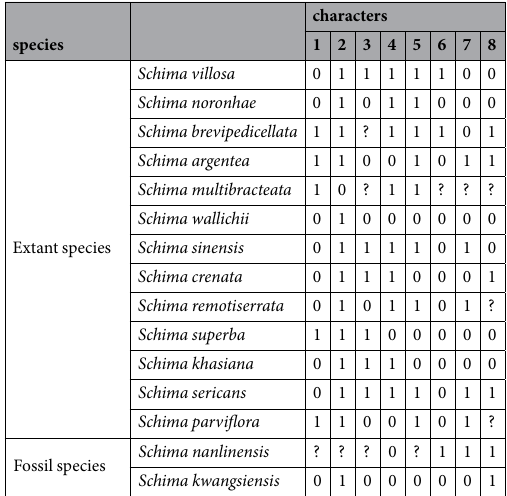
Table 3. Data matrix for character states of Schima .